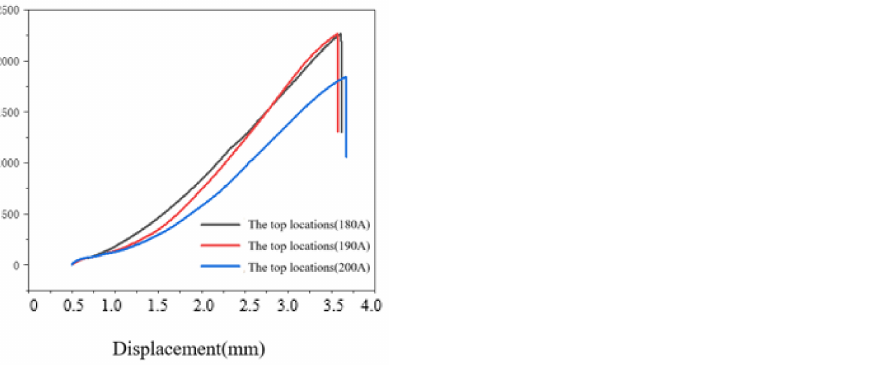
Figure 14. Tensile curves for top locations of deposited samples fabricated using different currents.